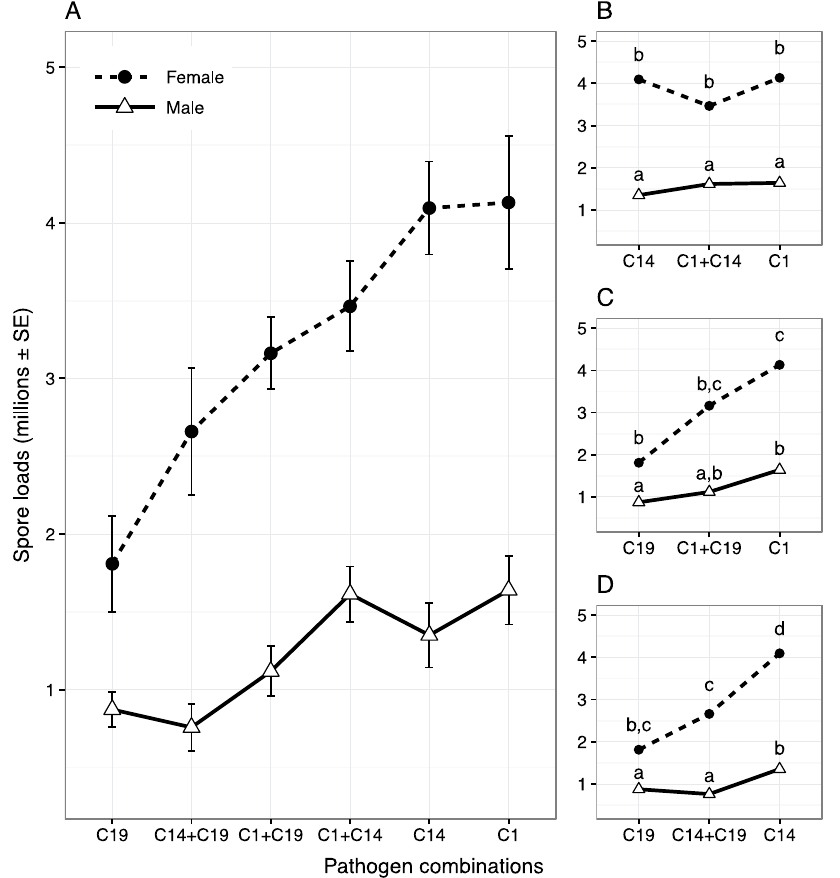
Figure 1. Transmission spores at death for all co-infection treatments. Pathogen combinations in panel A are ordered by spore loads in infected females (left to right, lowest to highest). Panels B to D show the same results subset by the co-infection combinations, with lower-case letters indicating significant groupings via post-hoc t-tests and Benjamini & Hochberg adjusted p-values.